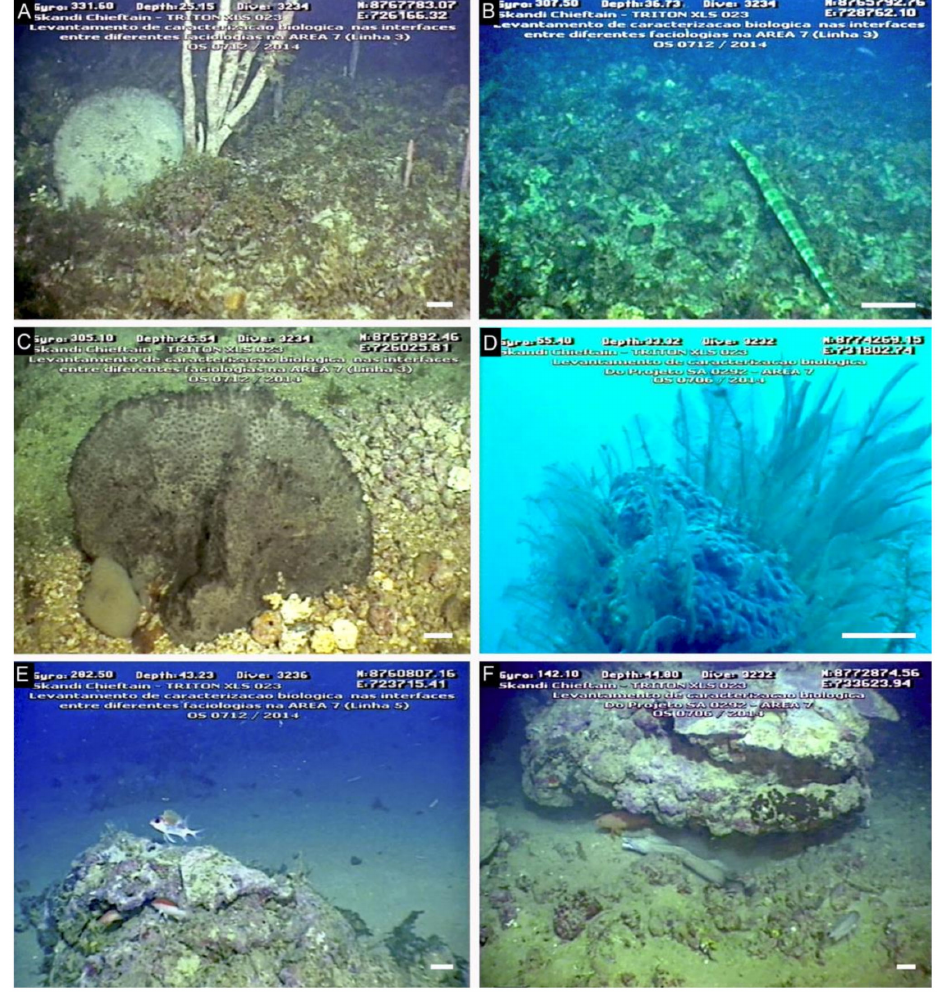
Figure 3. In situ images of the benthic community associated with the rhodolith beds on the south sector of the SEAL Basin: ( A , C , D ) Fleshy macroalgae, corals ( Montastraea cavernosa ) and sponges ( Aplysina sp. and Ircinia strobilina ) occur from 25 m to 30 m depth; ( B , E , F ) A reef fish community ( Aulostomus maculatus, Holocentrus adscensionis, Gymnothorax moringa and Cephalopholis fulva ) occurs from 36 to 44 m depth. Scale bars = ~5